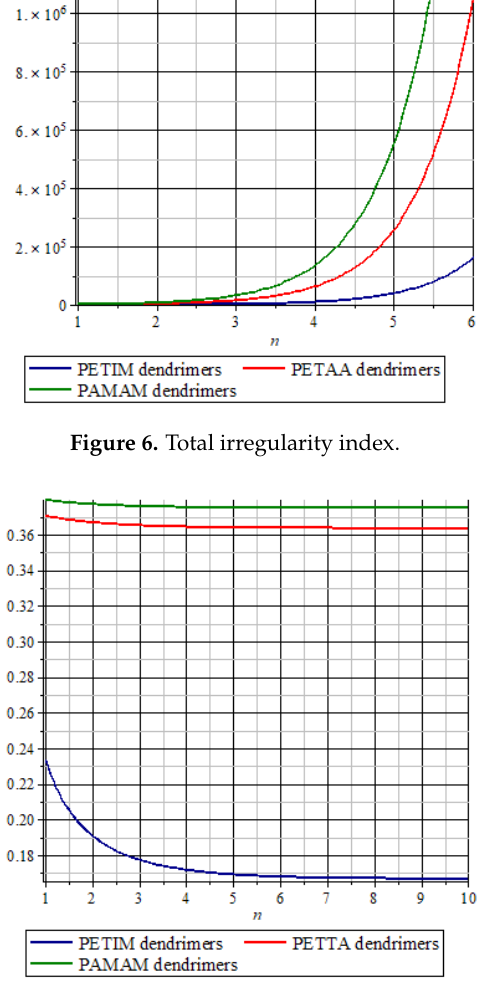
Figure 7. Variance